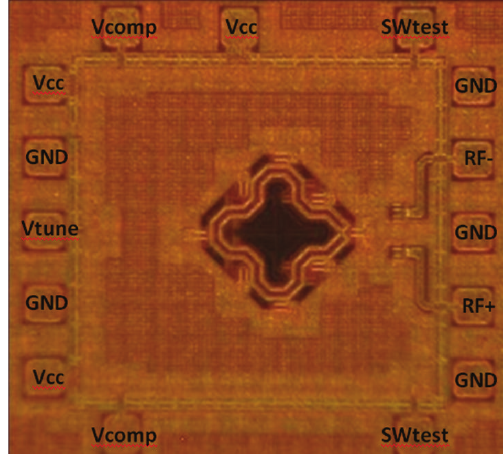
Figure 10: RTW VCO phase noise measurement.